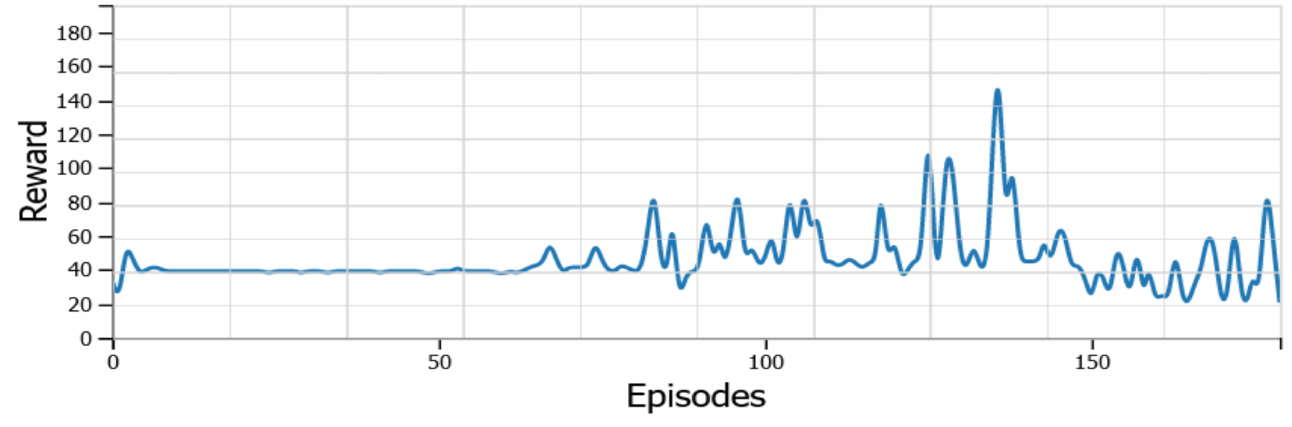
Figure 8. Reward and